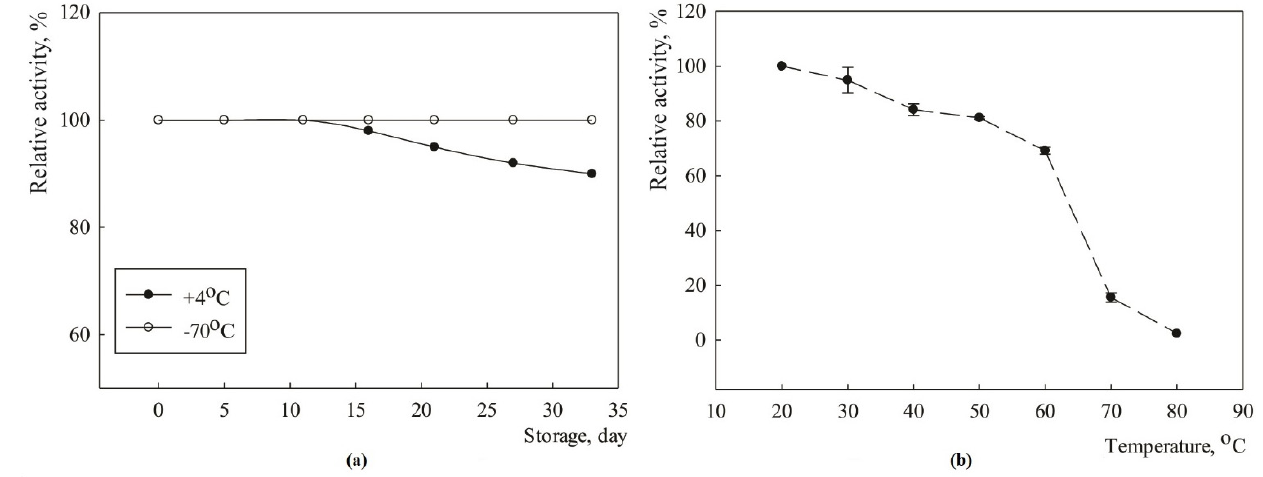
Figure 3. Stability of MDH-His 6 -tag (1.3 mg/mL): ( a ) Upon storage in 25 mM potassium phosphate buffer solution (pH 6.5) at +4 ◦ C without stabilizing agents, and at − 70 ◦ C with 50% glycerol supply; ( b ) Thermostability of MDH-His 6 -tag at pH 8.0. Activity of the non-heated enzyme was defined as 100%.